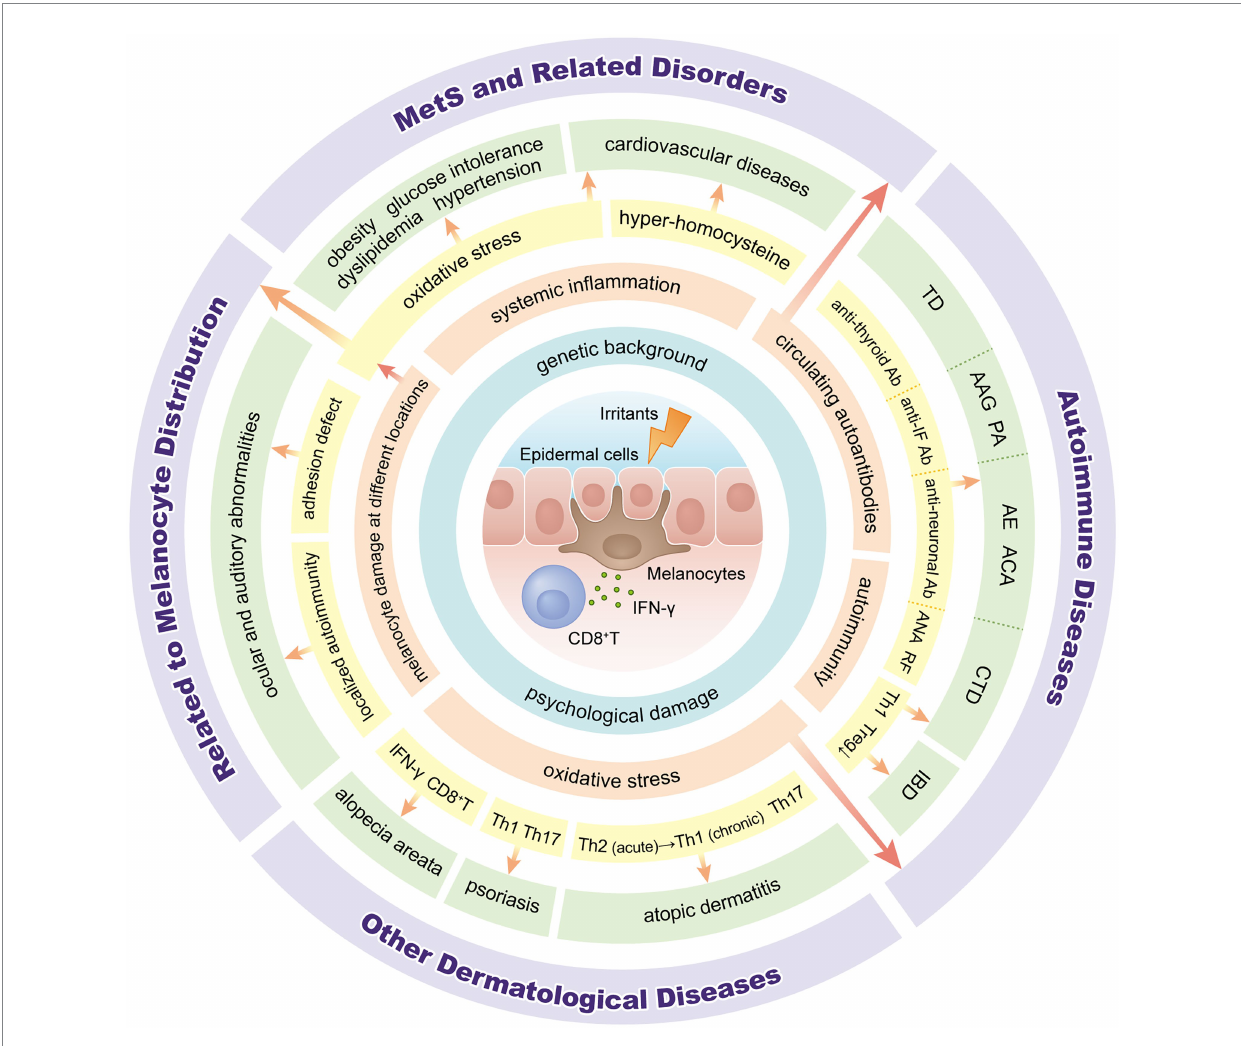
FIGURE 2 Overview of pathogenesis between vitiligo and associated comorbidities. IFN: interferon; Ab: antibody; IF: intrinsic factor; ANA: anti-nuclear antibody; RF: rheumatoid factor; Th: T-helper; Tregs: regulatory T cells; TD: thyroid disease; AAG: autoimmune atrophic gastritis; PA: pernicious anemia; AE: autoimmune encephalitis; ACA: autoimmune cerebellar ataxia; CTD: connective tissue diseases; IBD: inflammatory bowel disease; MetS: metabolic